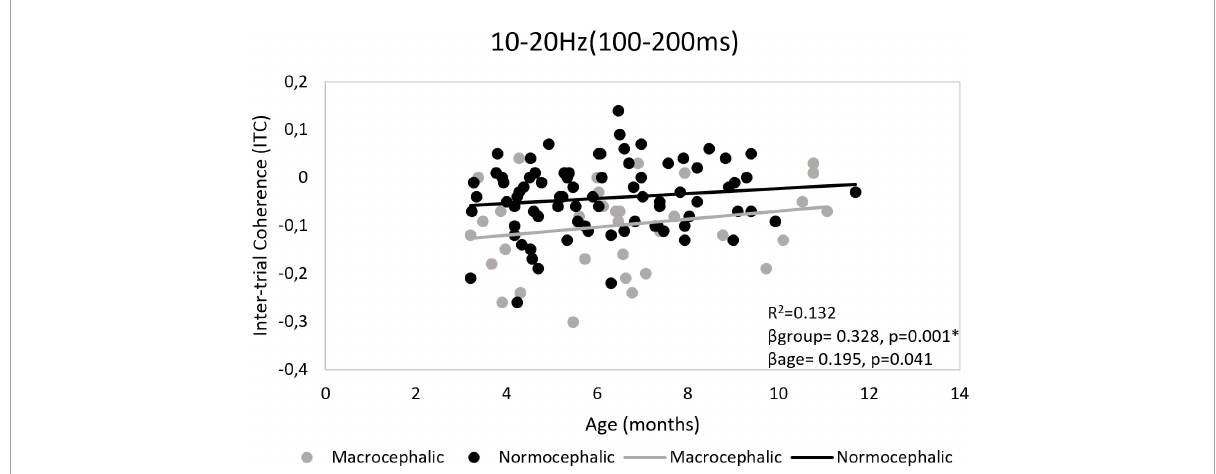
FIGURE3 Right frontal region. Ten to twenty Hertz time-frequency window (TFW). Scatter plot illustrating group effect for Inter-trial phase coherence (ITC). Control infants showed less repetition suppression than macrocephalic infants. Repetition suppression was calculated as the difference between the response to the second and first presentation (second – first). *Adjusted p- value < 0.0125.